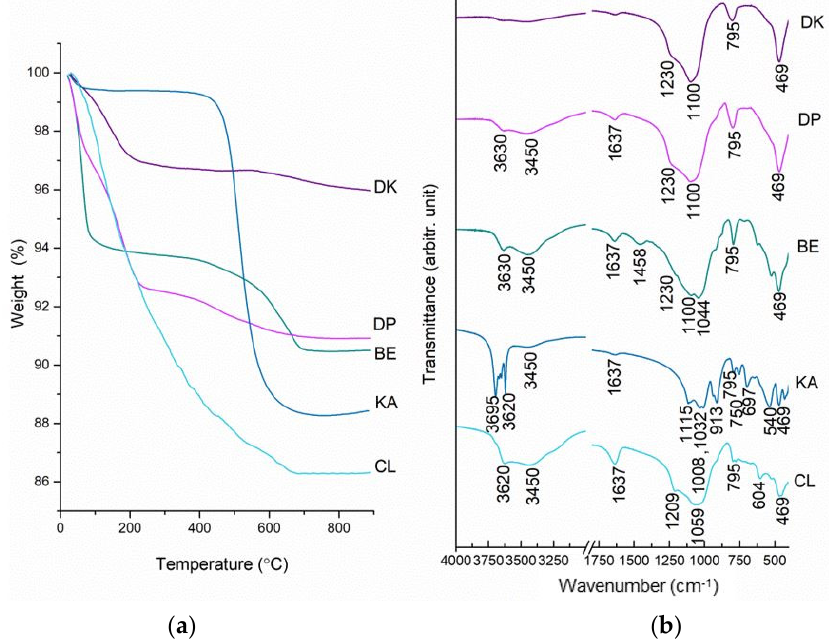
Figure 1. TG profiles ( a ) and FTIR spectra ( b ) of natural silicates—clinoptilolite (CL), Peru diatomite (DP), Kolubara diatomite (DK), kaolin (KA) and bentonite (BE).